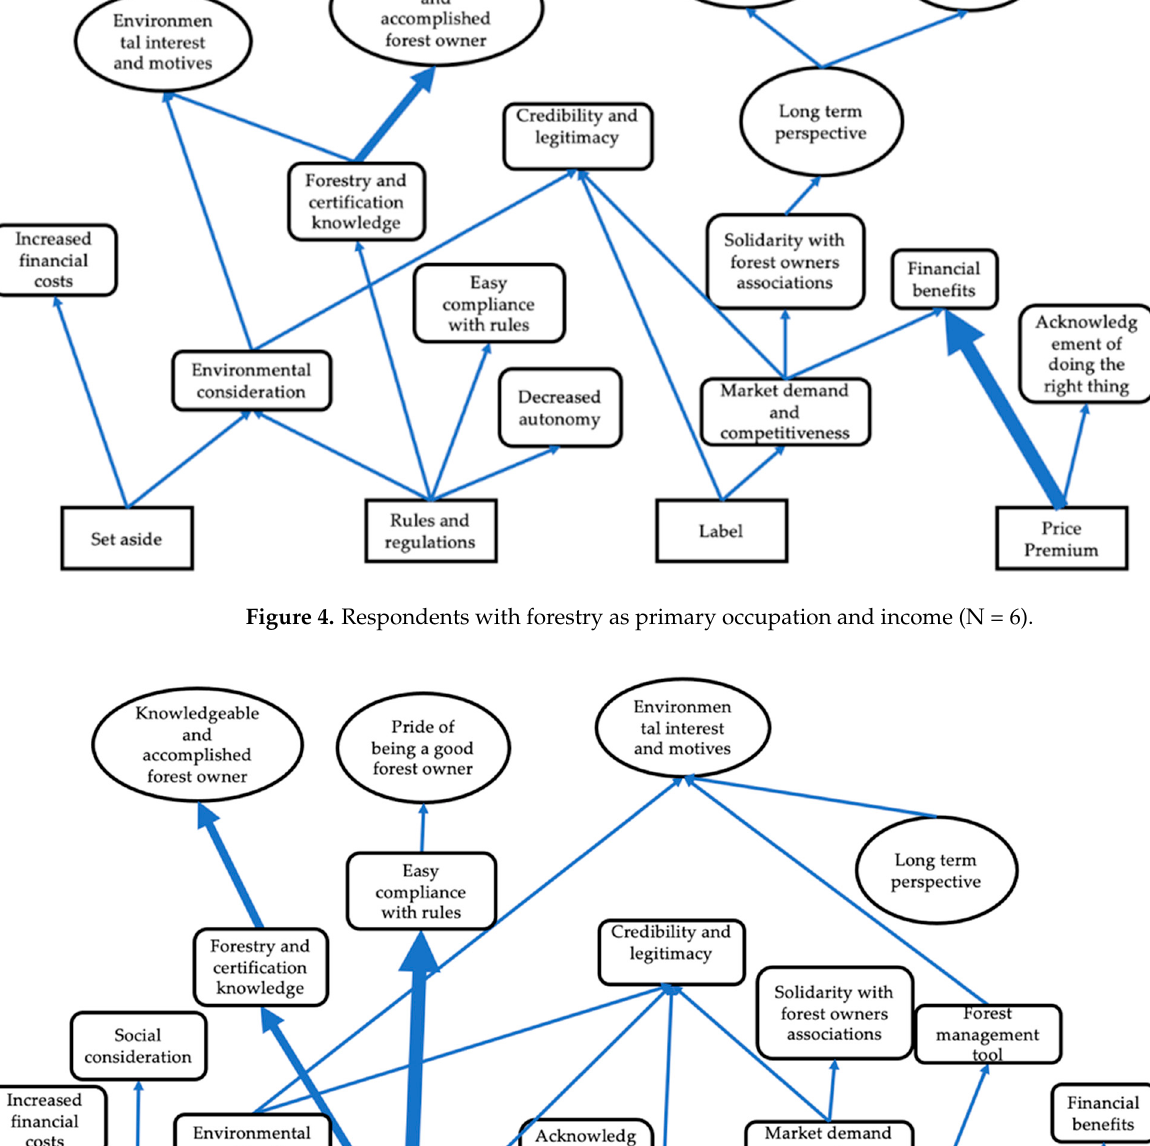
Figure 3. Hierarchical value map for men (N = 6).